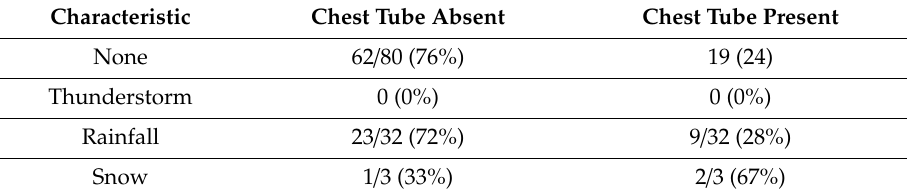
placement after CT-guided lung